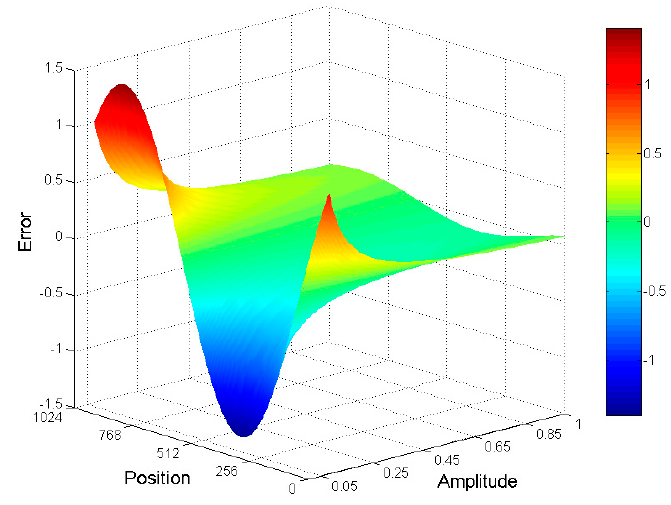
Figure 2. Subdivision error of the precision code signal when its amplitude is insufficient.